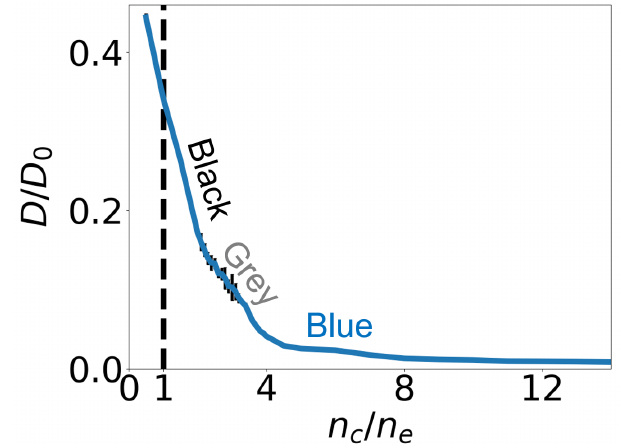
Figure 4. The specific entropy (“darkness”) index D normalized to its initial value D 0 for a scan of the density ratio values n c / n e ∈ [ 0.5,14 ] for laser intensity a 0 = 1 and a resonant pulse length. The plotted index is the mean of the calculated index for the last ten time steps in each run. The black error bars represent one standard deviation of this set of averaged values. Rough indications of the wave type for particular regions are given in text. Because the plasma is initialized with the same temperature in each case, the initial index D 0 is the same for every data point. The critical density is marked by a dashed